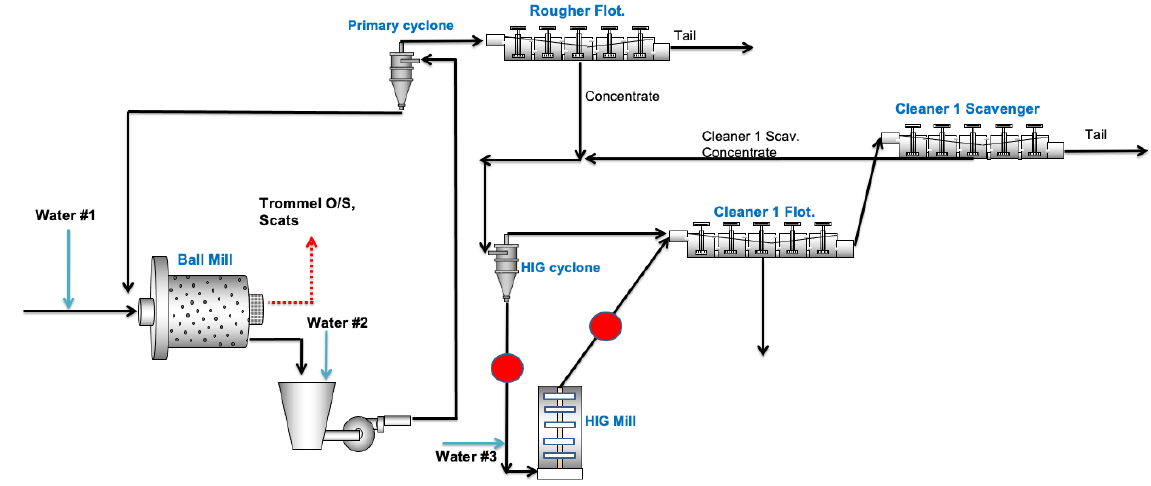
Figure 2. Flowsheet of milling & beneficiation circuit of the copper mine with HIGMill.